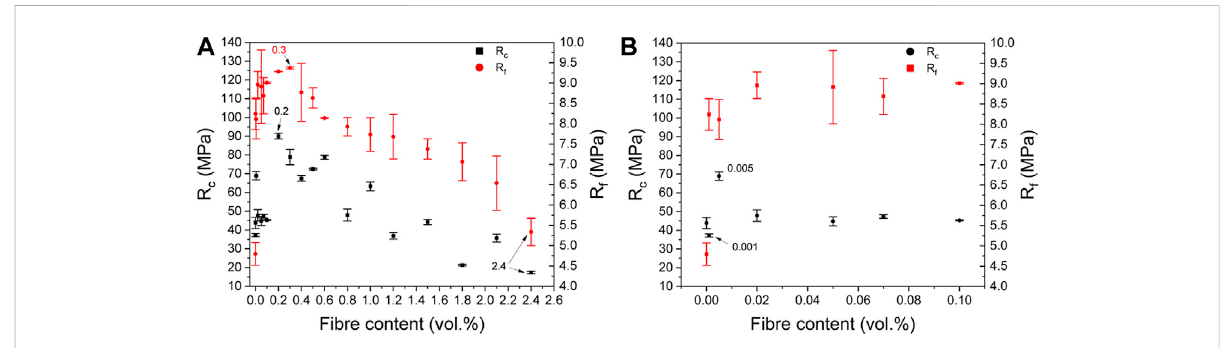
FIGURE 9 ArithmeticmeansandstandarddeviationsofcompressivestrengthR c and fl exuralstrengthR f for (A) smartcement-basedcompositeswith fi